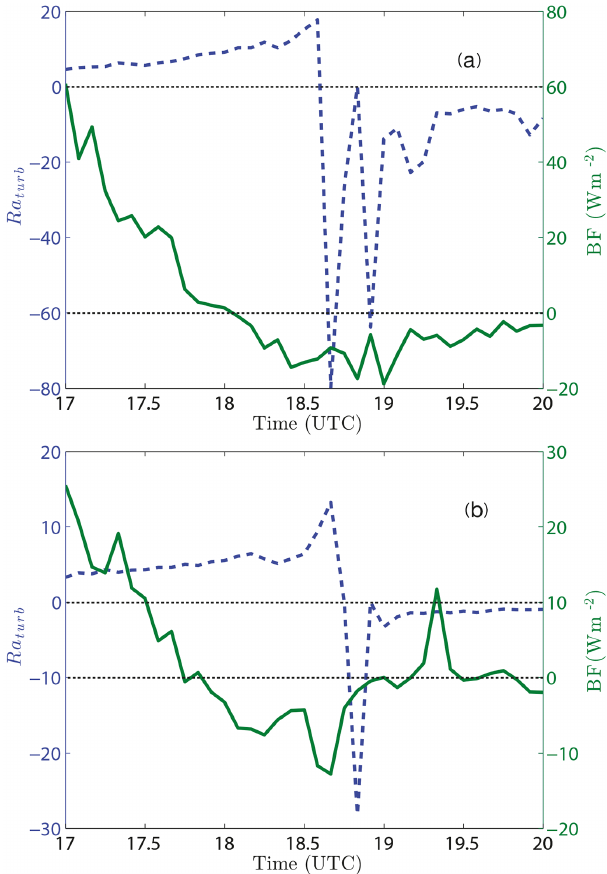
Figure 8. Temporal evolution of buoyancy flux at 2.23m (green) and Ra turb (blue) during the evenings of (a) 30 June and (b) 1 July 2011.